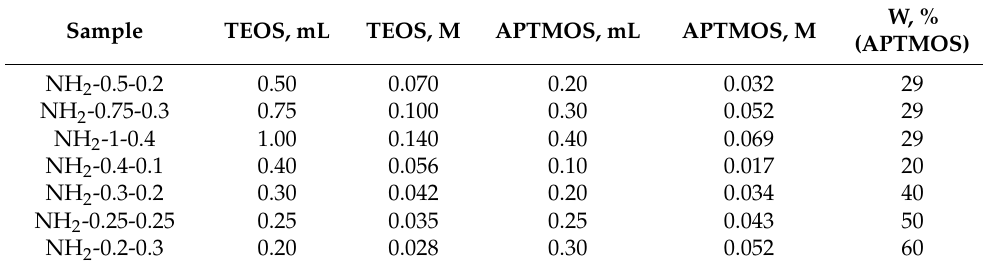
Table 3. Conditions for the synthesis of SiO 2 –C 3 H 6 –NH 2